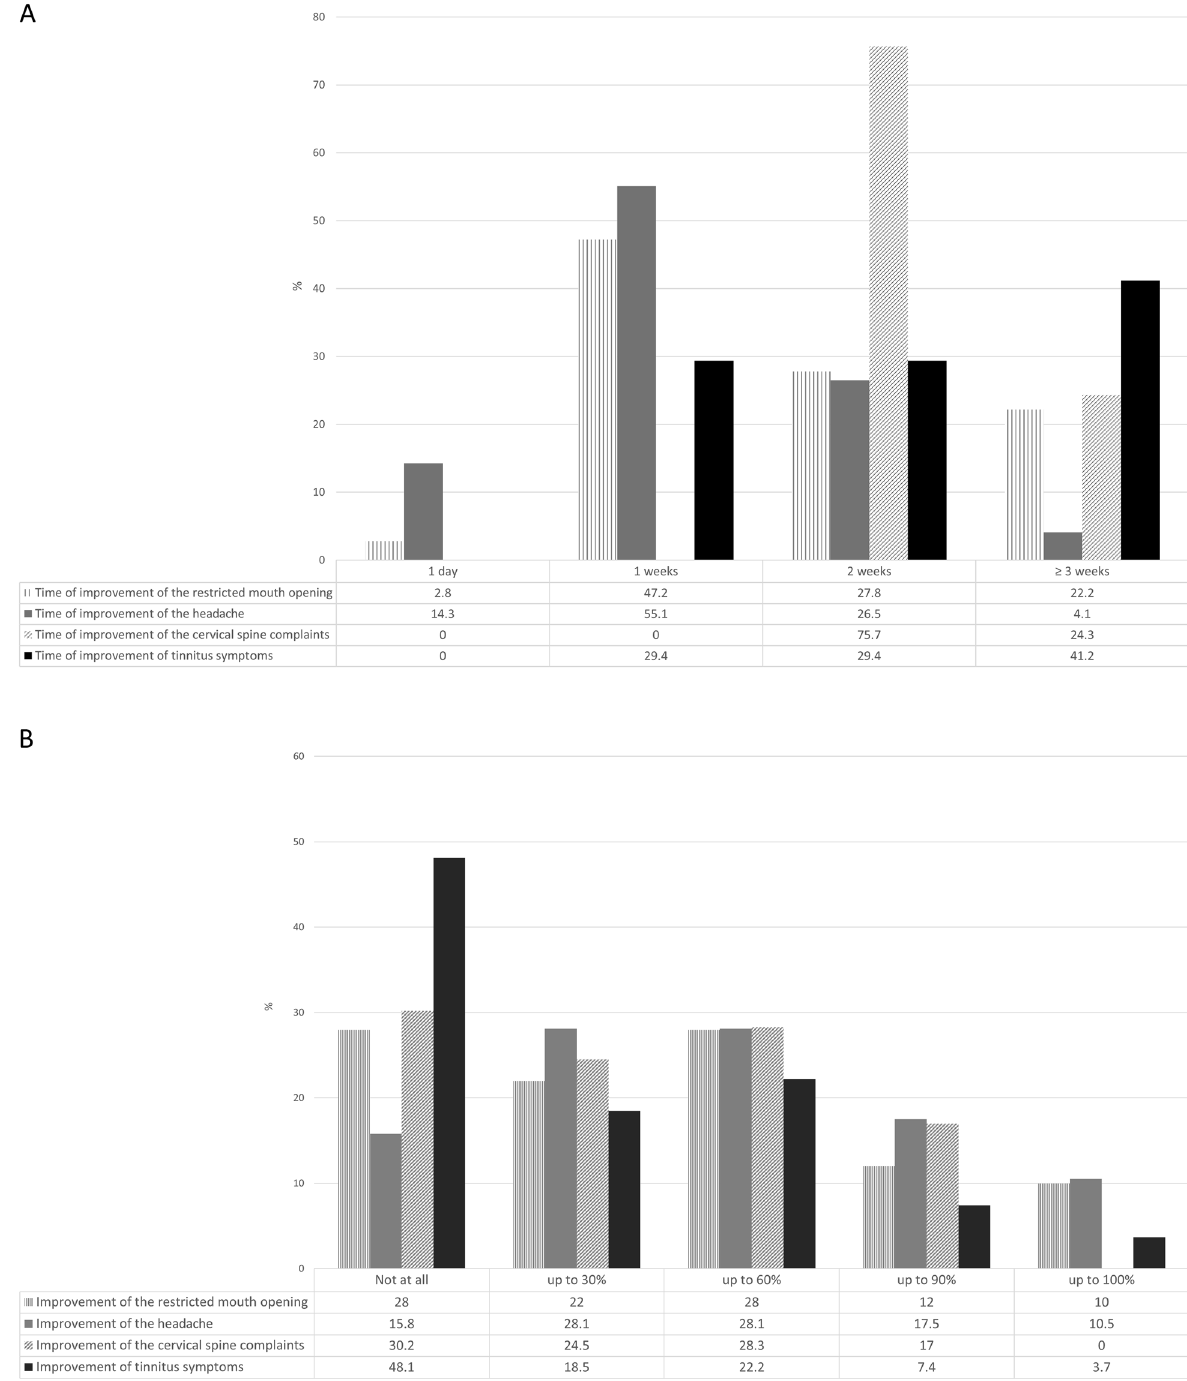
Fig. 2 Results of the analyzed questionnaire. A Frequency of subjective symptom improvements with regard to the time course of treatment. B Extent of subjective symptom improvement for the different effects have already been observed using other types of occlusal splints [38]. The authors suggested that improvement of clicking noise may be attributable to morphological changes of the disc itself, eliminating the physical barrier for jaw translation and thus decreasing the sound intensity of TMJ clicking. Previous studies have shown that headache and TMDs are